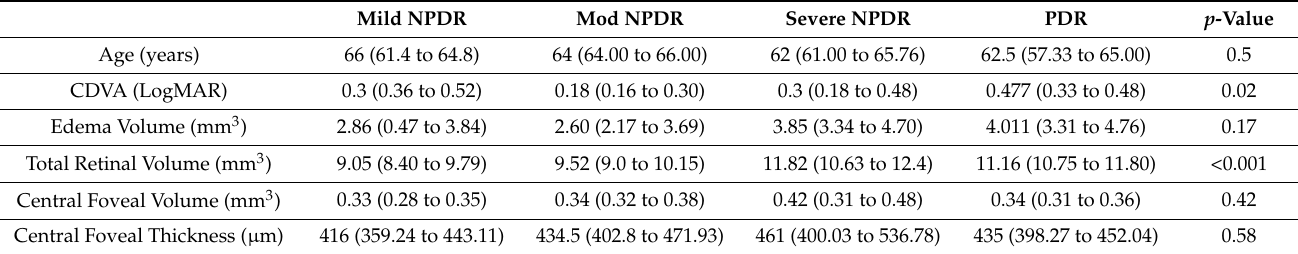
Table 1. Median with range of indices for the ETDRS grades of diabetic